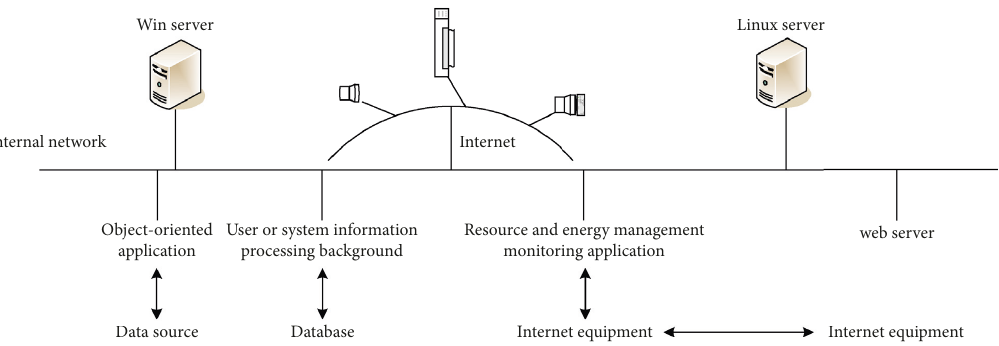
Figure 2: Web service